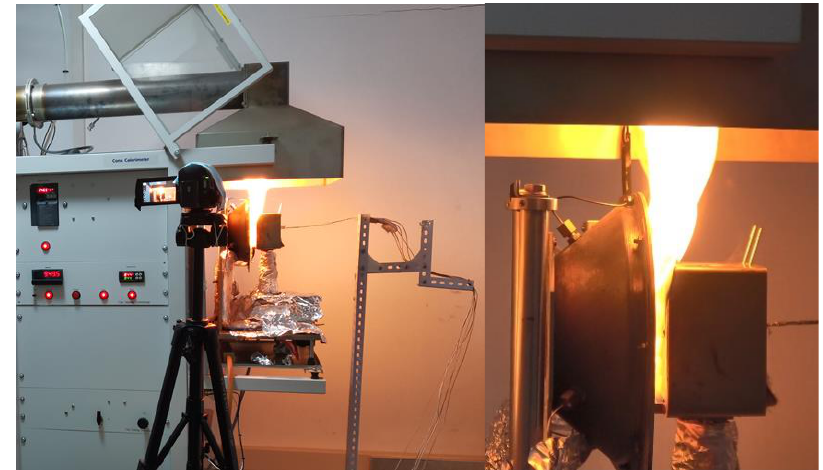
Figure 9. Cone calorimeter experiment.